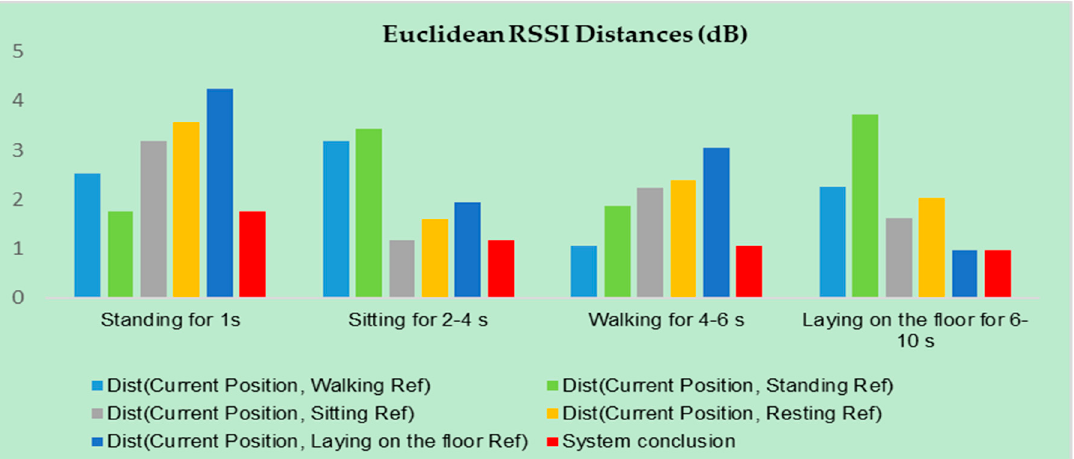
Figure 10. Detection of concurrent target position over a measured time.